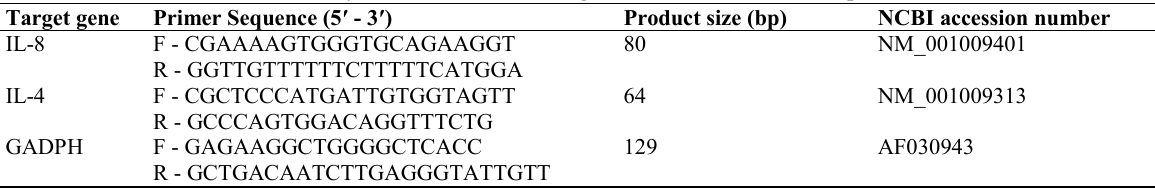
Table 2. Primer characteristics of cytokines and reference gene for real-time PCR amplification . Target gene